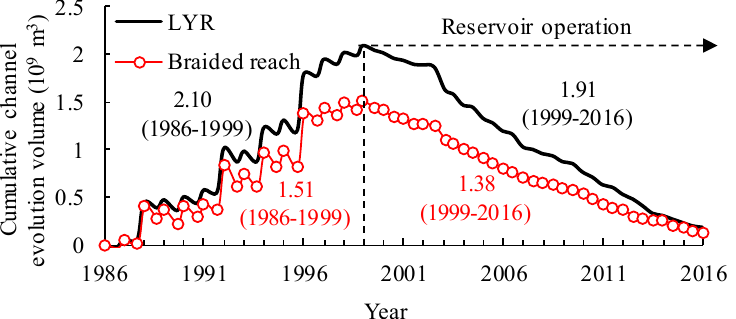
Figure 4. Cumulative volume of bed deformation in the braided reach and the LYR during the period 1986–2016.